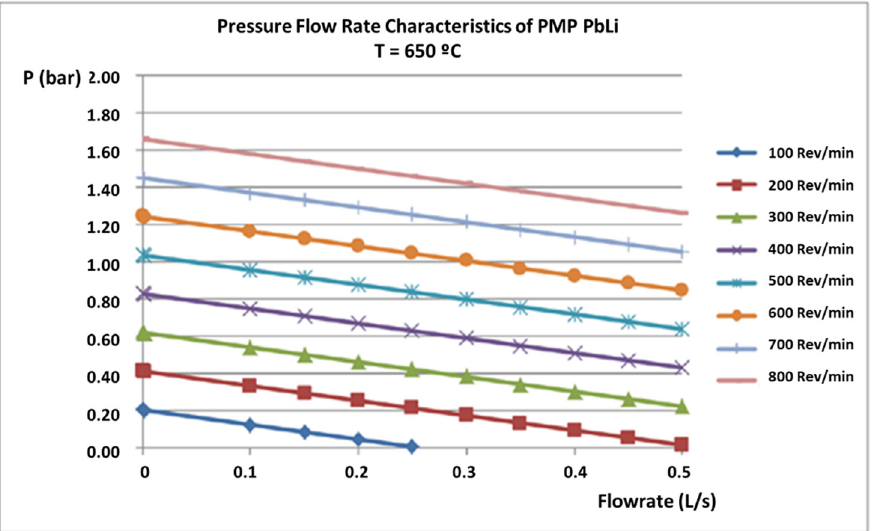
Figure 2. Pressure vs. flow rate variation characteristic curves of the permanent magnetic pump, by SAAS GmbH.